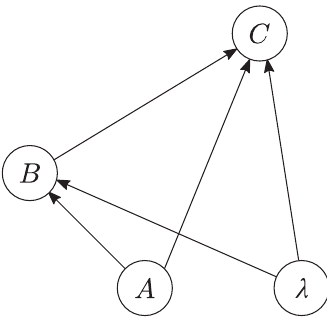
FIG. 11. The causal structure of Fig. 10 with an extra node λ , which is a common cause for B and C . A causal model with this DAG may describe a qubit interacting with an environment: A , B , C represent the qubit system at three different times and λ the environment at the initial